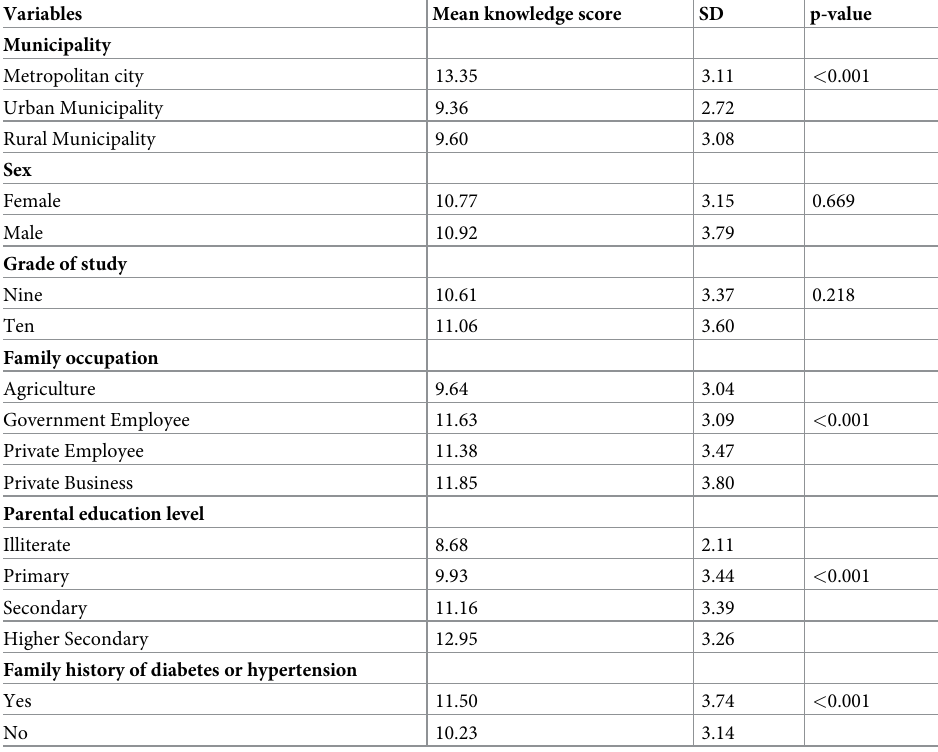
Table 3. Respondents’ knowledge score on diabetes and hypertension by socio-demographic characteristics.